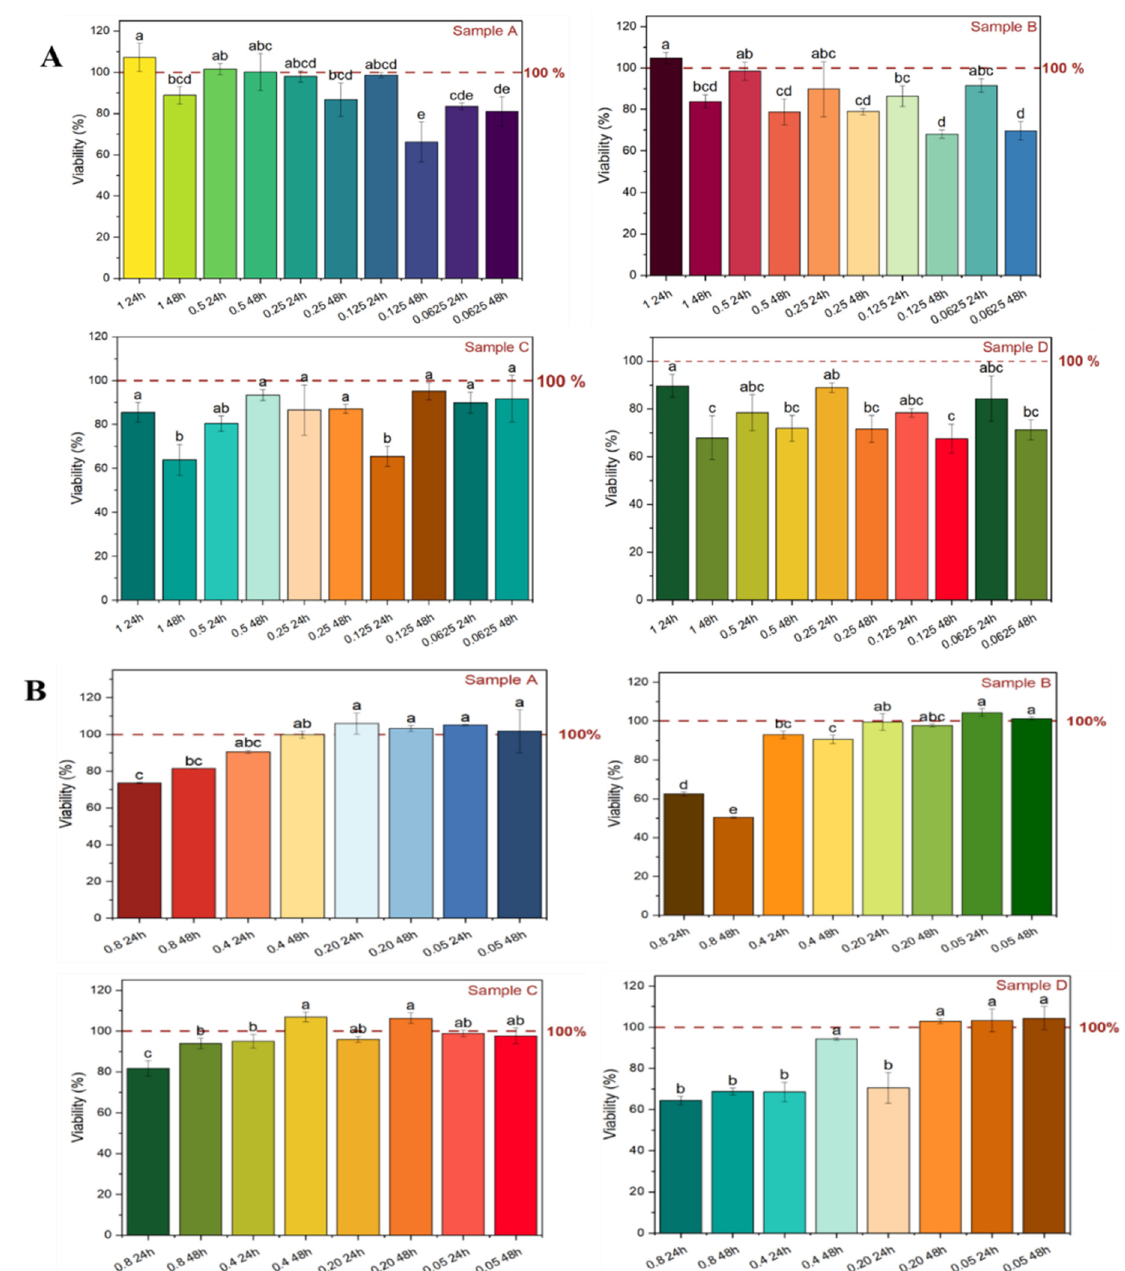
Figure 5. Cell viability of ( A ) fibroblasts 3T3-L1 and ( B ) NS-SV-AC cell lines exposed under ethanolic extract of apple pomace fractions at different concentrations during 24 h and 48 h; sample A (pulp, peel, seed, core, and stem), sample B (peel), sample C (seed and core), and sample D (pulp and peel); control was considered 100%; mean values with different letters show significant difference at p < 0.05.